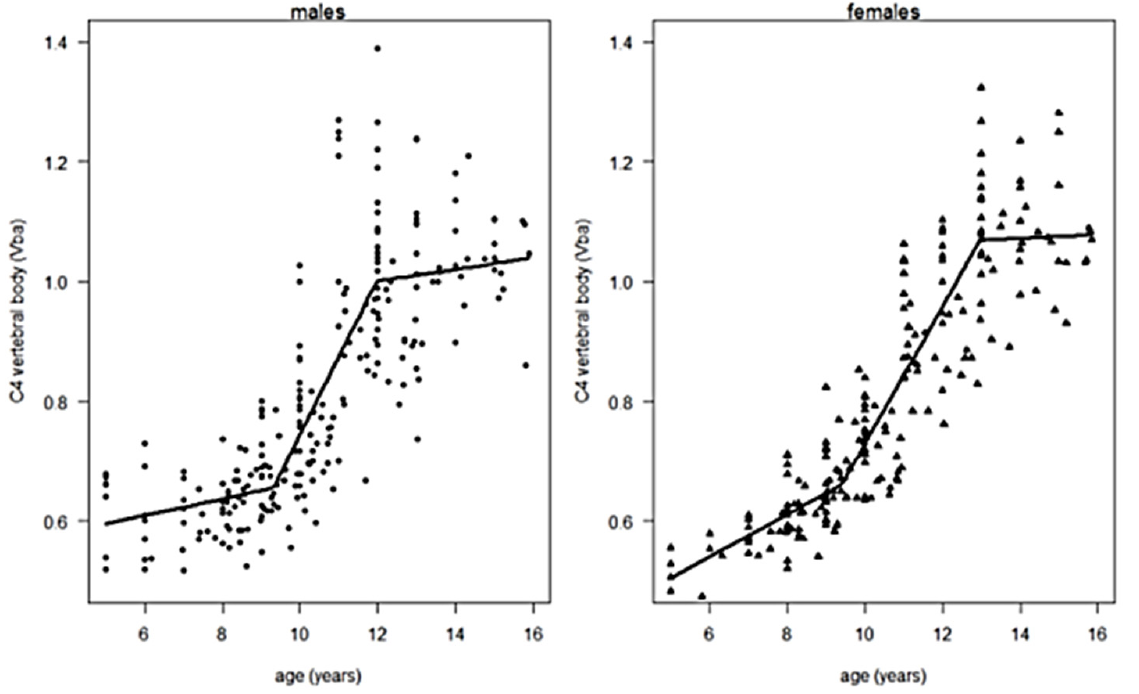
Figure 3. The distribution of the proportions of the anterior and posterior sides of the C4 vertebral body ( Vba ) as the function of age for males ( left ) and females ( right ) subjects with segmented regression plots.